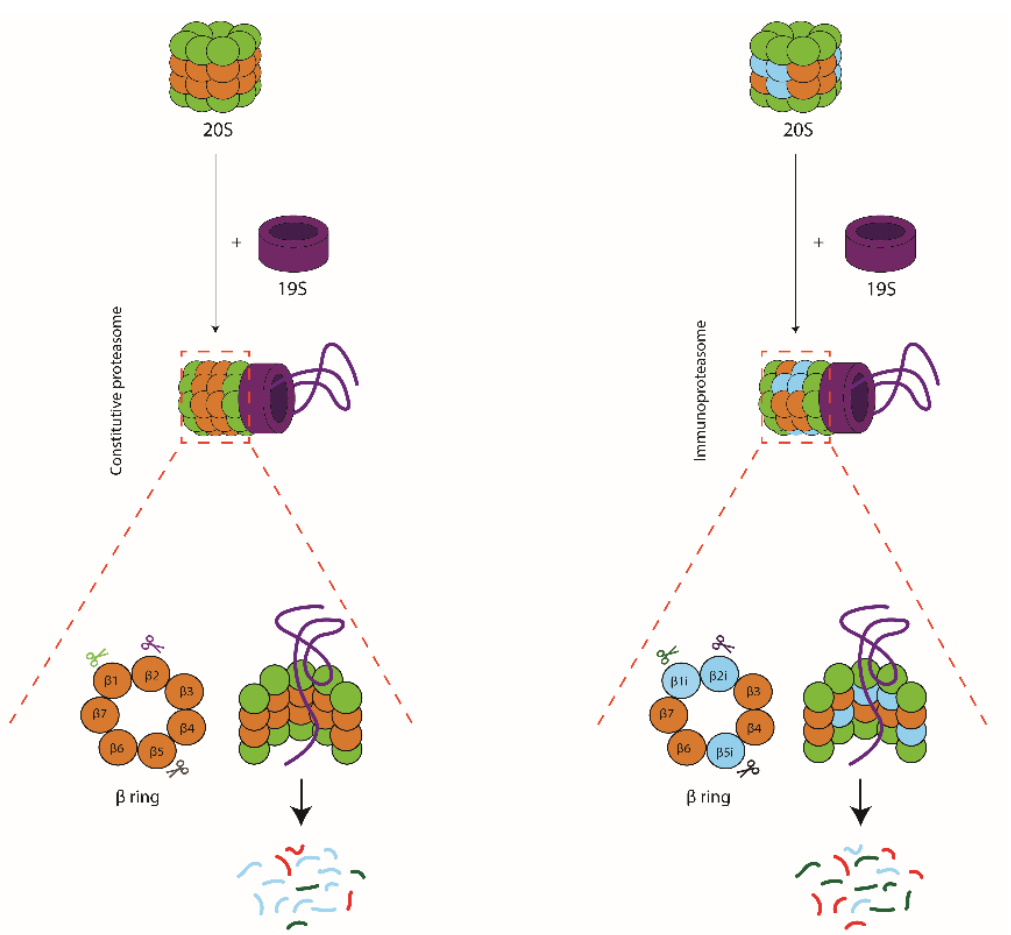
Figure 2. Schematic representation of 26S proteasomes, consisting of a 20S catalytic core particle attached to a 19S regulatory particle. Substrates are captured by the 19S complex, unfolded, and translocated into the 20S lumen where they are degraded by the catalytic subunits β 1, β 2, and β 5 in constitutive proteasomes (left hand panel) or LMP2/ β 1i, MECL-1/ β 2i, and LMP7/ β 5i in immunoproteasomes (right hand panel). The two types of proteasomes share most cleavage sites but use these with distinct frequencies, leading to a very different representation of the single peptides within the pool of degradation products.